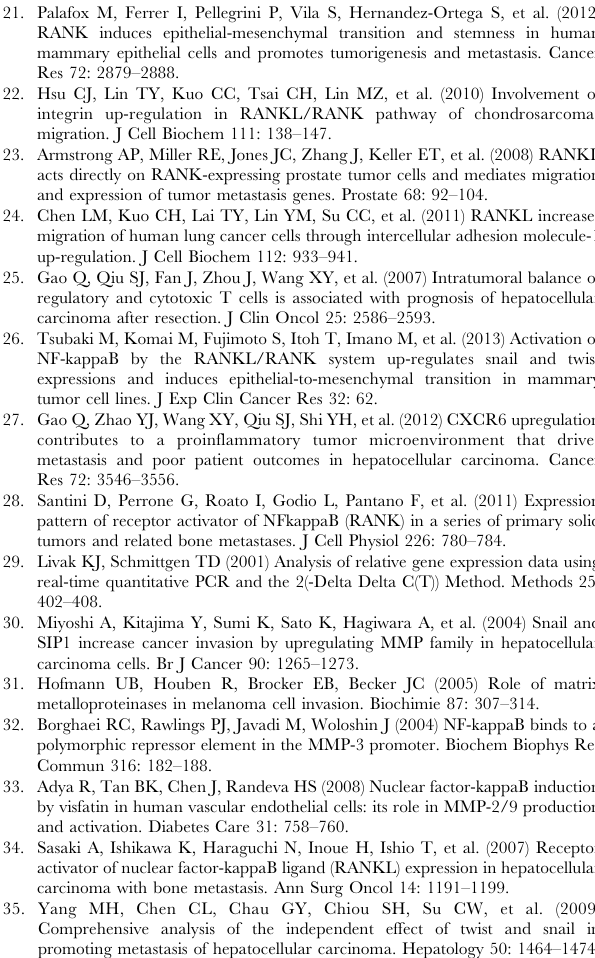
Table S1 Sequence of primers for qRT-PCR. Table S2 Primary antibodies for Western blot